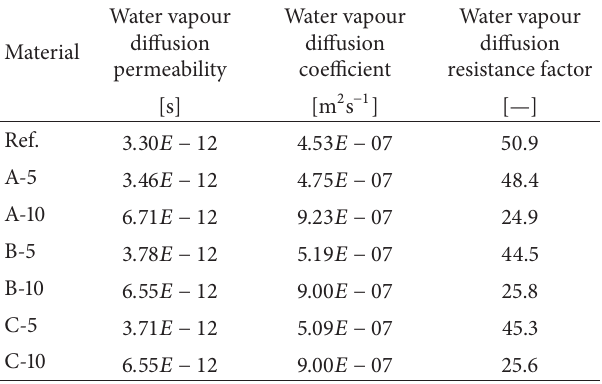
Figure 2: Pore size distribution curve. Table 8: Water vapour transport parameters: dry-cup arrangement.